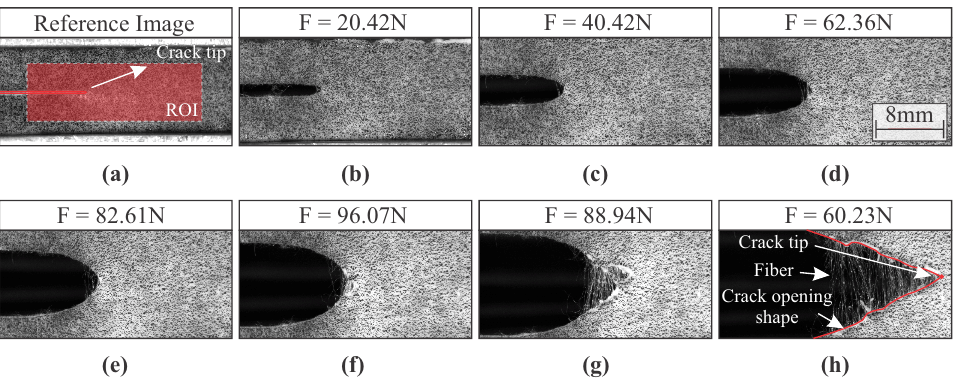
Figure 7. Crack growth in a fibrous hyperelastic soft composite with fibers oriented at 90 ◦ : ( a ) un- deformed state with depicted Region of Interest (ROI); ( b ) deformed states with applied loads of 20.42 N; ( c ) 40.42 N; ( d ) 62.36 N; ( e ) 82.61 N; ( f ) 96.07 N; ( g ) 88.94 N; ( h ) 60.23